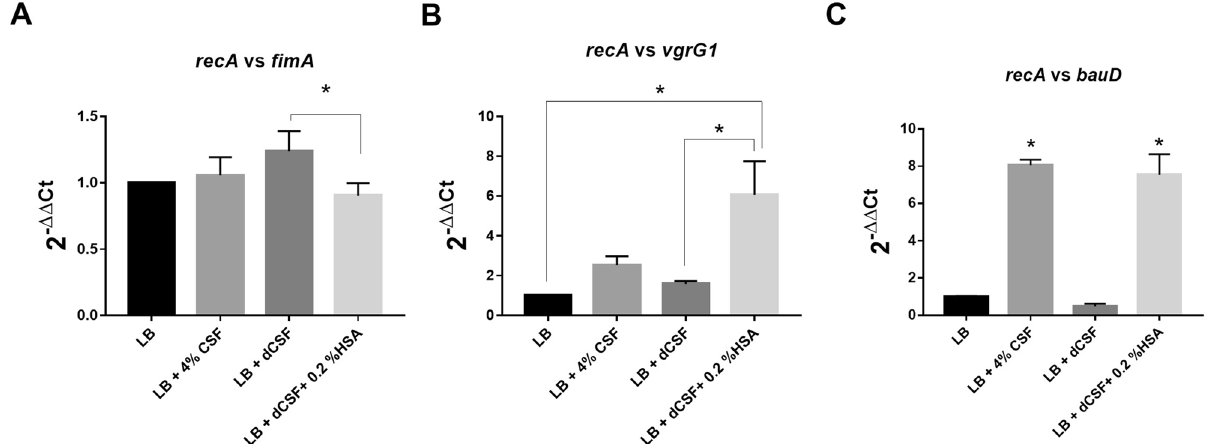
Figure 3. HSA is an essential component for the differential expression of genes in A. baumannii . A. baumannii A118 cells were cultured in LB or LB supplemented with one of the following: 4% CSF, HSA-depleted CSF (dCSF), or dCSF + 0.2% HSA and its cDNA was synthesized. RT-qPCR was conducted with three genes ( A ) fimA encoding gene, ( B ) vgrG1 , and ( C ) bauD. Shown are the means of the results obtained from three independent experiments. The y axis refers to the fold difference of each gene to the threshold cycle (C T ) values corresponding to recA ; the standard deviation SD is shown. Asterisks indicate significant differences among treatments, as determined by ANOVA followed by Tukey’s multiple comparison test ( P <